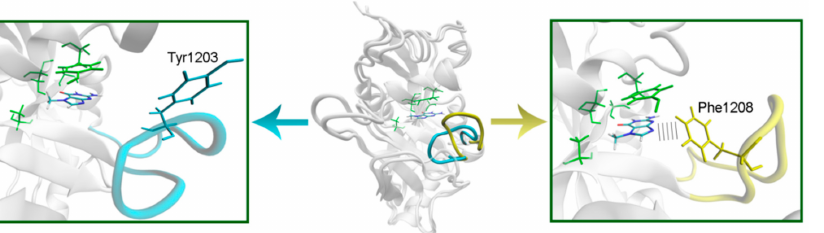
Figure 5. D-loop conformation in PARP-5a and its interaction with the NA binding site revealed by MD modeling. The NA site residues are colored in green, D-loop conformation I is shown in blue, conformation II in yellow.